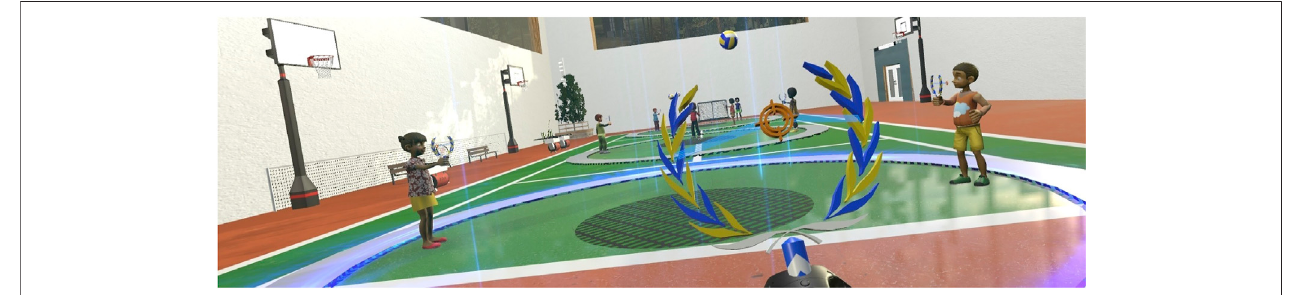
FIGURE 7 | Slingshot, ball and play areas of the gymnasium during the Cyberball